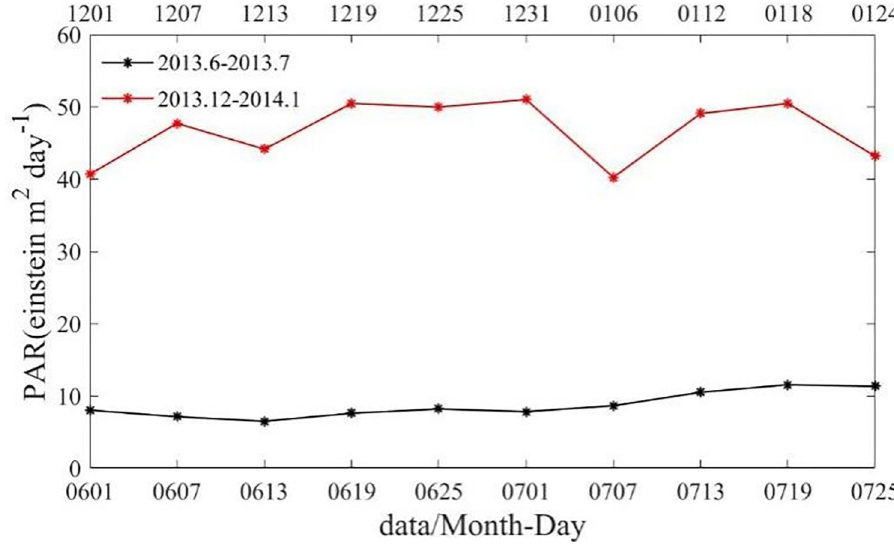
Fig 10. Time series of spatially averaged PAR in Box B in June and July 2013 (black line), December 2013 and January 2014 (red line).